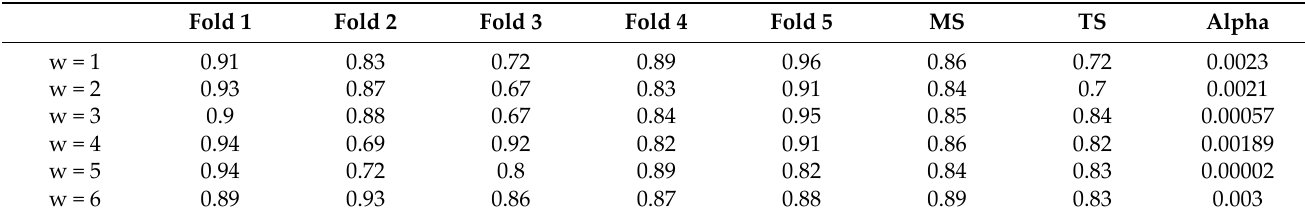
Figure 8. Decision tree generation in pattern 2. Table 2. R 2 of Cross validation and grid search of LASSO.